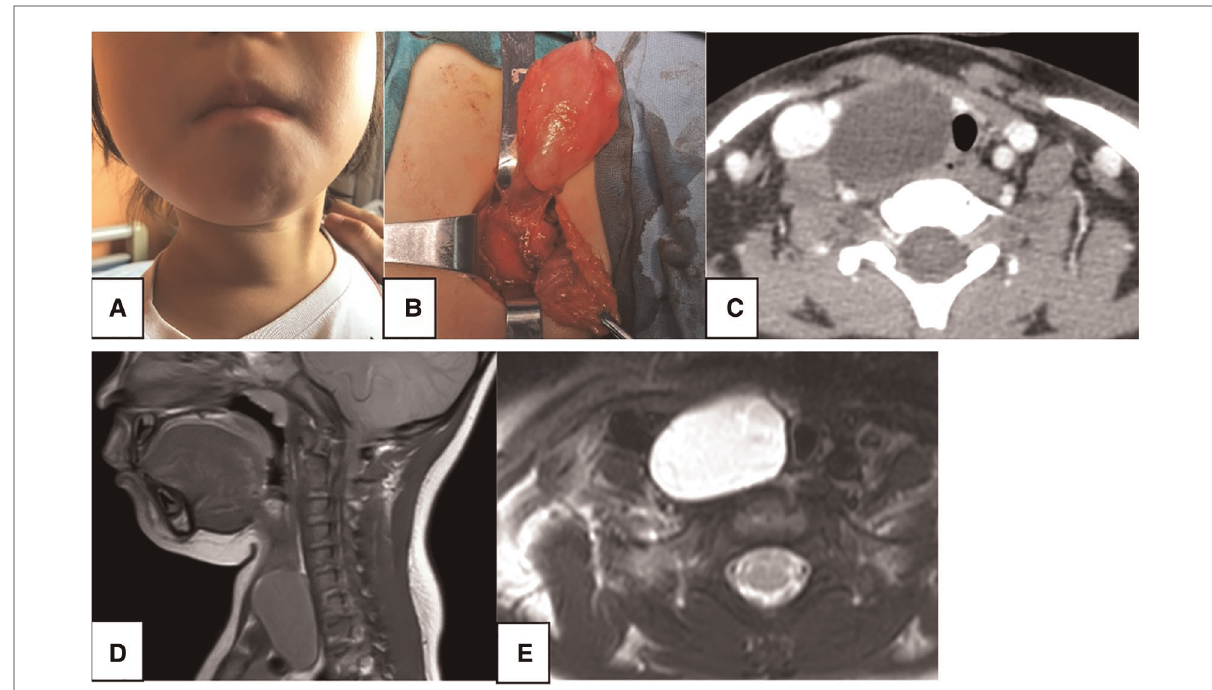
FIGURE 5 A 2.9-year-old female. CT showed a 4.2-cm sized homogeneous, low-density mass ( C , white arrow) with thin walls and smooth borders in the right neck region without enhancement, and misdiagnosed as lymphangioma. The right thyroid was compressed and deformed, and the trachea ( C,E , red circle) shifted to the opposite side. MRI showed low signal intensity on T1WI ( D , white arrow) and high signal intensity on T2WI ( E , white arrow). ( A ) preoperative neck mass; ( B ) intraoperative mass; ( C ) axial contrast-enhanced CT; ( D ) sagittal T1WI MRI; ( E ) axial T2WI MRI.